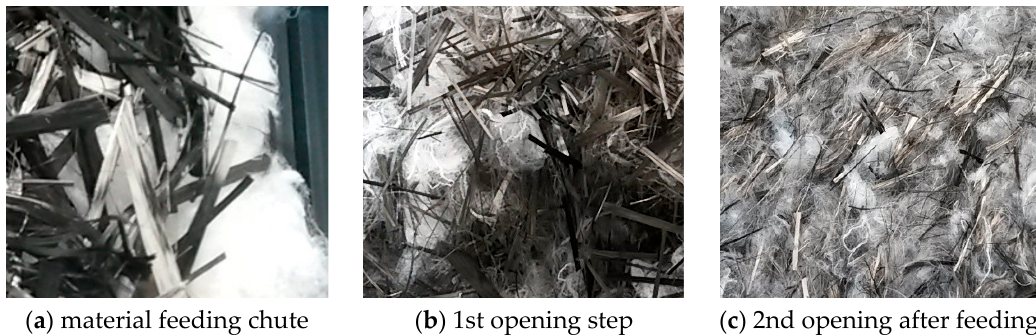
Figure 5. Feeding ( a ) first ( b ) and second ( c ) opening and mixing process of carbon (black) and rPA6 (white) fibers.